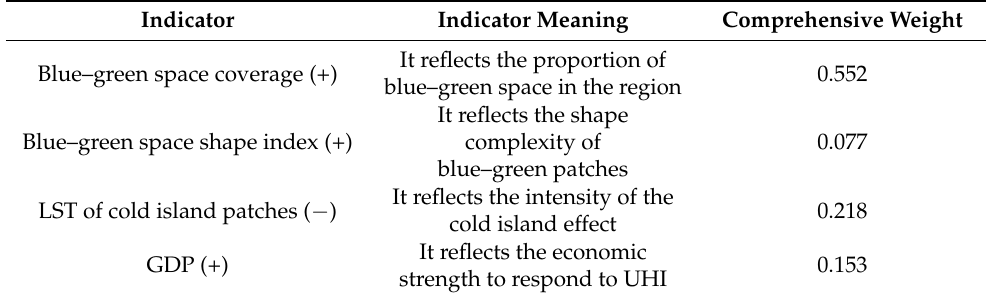
Table 1. Cold island supply capacity (CIS) index